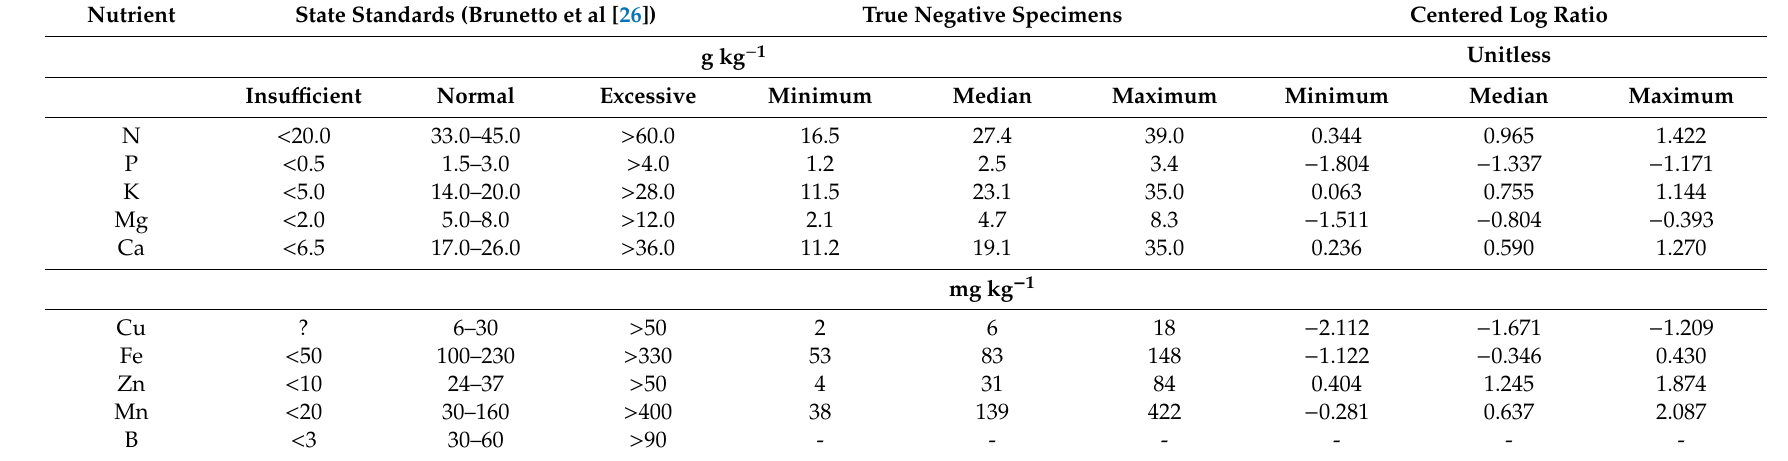
Table 6. Foliar nutrient levels for state standards and in 142 true negative specimens of peach orchards in Rio Grande do Sul, Brazil, compared to current